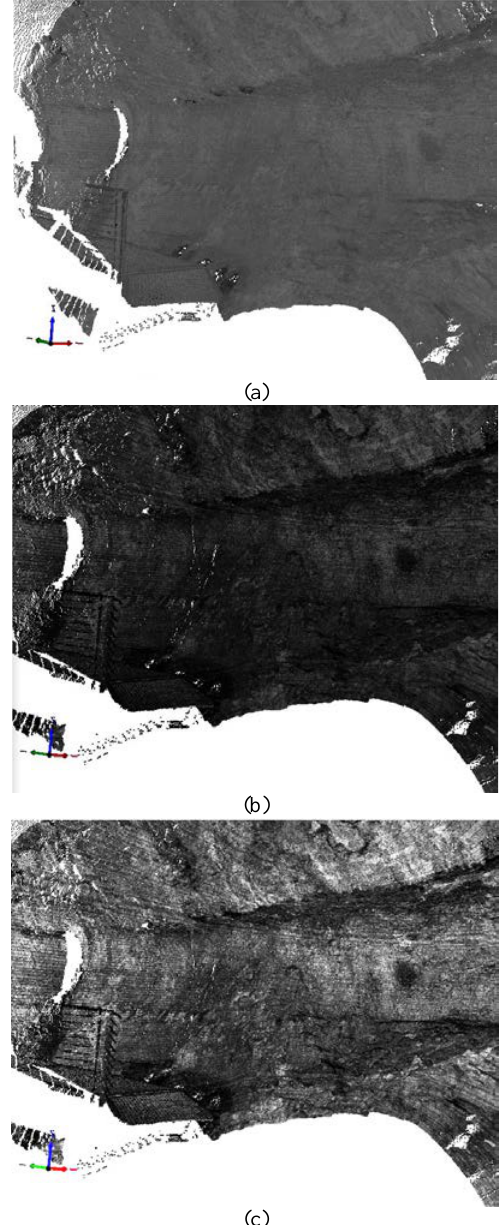
Figure 8. Partial Remigia Cave point cloud: a) Initial intensity values; b) Corrected intensity values; c) Corrected intensity image with histogram stretch